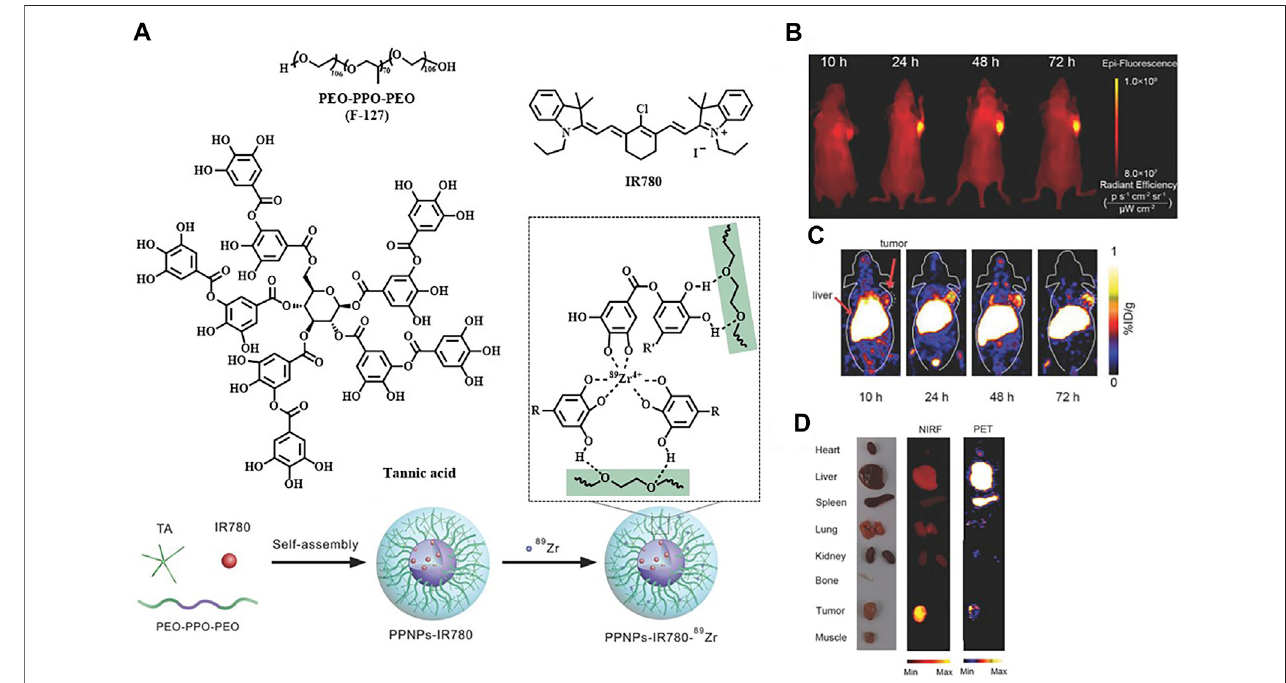
FIGURE5|(A) ConstructionofPPNPs-IR780- 89 Zr. (B) NIR fl uorescenceimagesofaSKBR3tumorbearingmousebypost – intravenousinjectionofPPNPs-IR780. (C) Serial coronal PET images. (D) Ex vivo biodistribution. Reproduced with permission from Wang X. et al. (2018). Copyright 2018, Wiley-VCH.